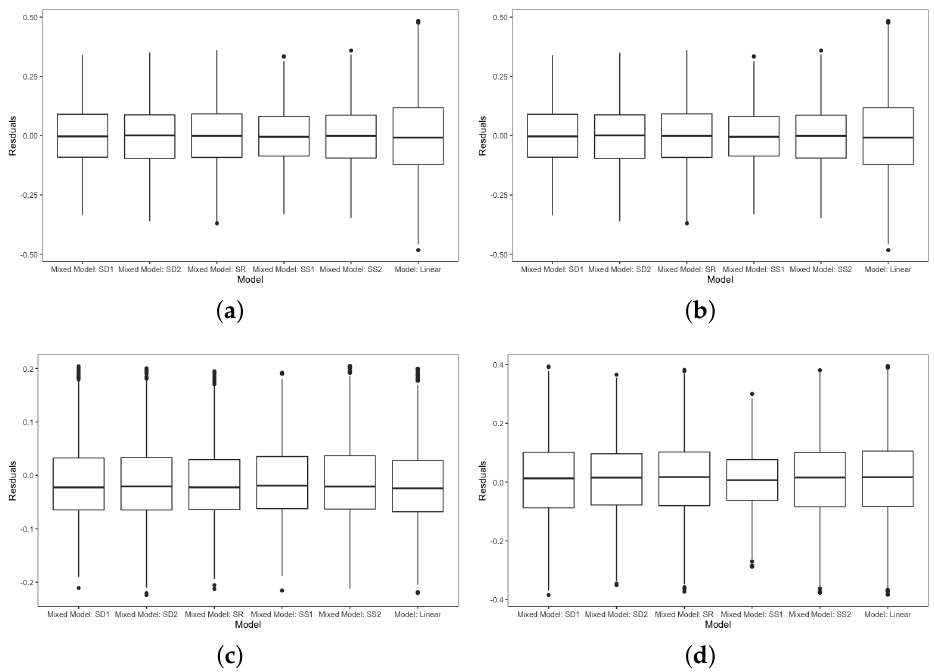
Figure 3. Box plot of model residuals fitting rice phenotypic traits. ( a ) Models fitting fresh weights. ( b ) Models fitting dry weights. ( c ) Models fitting plant height. ( d ) Models fitting green leaf